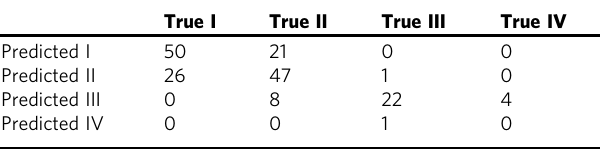
Table 2 Model accuracy in predicting the Gross Motor Function Classi fi cation System (GMFCS) score.